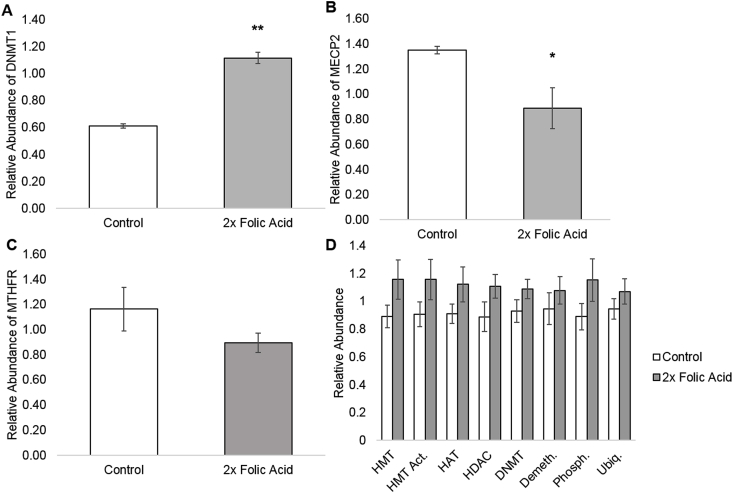
A. Relative abundance for DNMT1 mRNA expression measured by Taqman assay; p = 0.0038. B. Relative abundance for MECP2 mRNA expression measured by Taqman assay; p = 0.037. C. Relative abundance for MTHFR mRNA expression measured by Taqman assay; p = 0.14. D. Relative abundance of each gene grouping tested in the epigenetic chromatin modifying enzymes arrays. Gene groups tested were histone methyltransferases (HMTs, p = 0.058), HMT activity enzymes (HMT Act., p = 0.072), histone acetyltransferases (HATs, p = 0.074), histone deacetylases (HDACs, p = 0.061), DNA methyltransferases (DNMTs, p = 0.072), DNA/histone demethylases (Demeth., p = 0.17), histone phosphorylases (Phosph., p = 0.075), and histone ubiquitinases (Ubiq., p = 0.13). All Fig. 1 error bars are ± 1 standard error. A single asterisk (*) indicates p < 0.05, a double asterisk (**) indicates p < 0.01 using a paired two-tailed t-test.